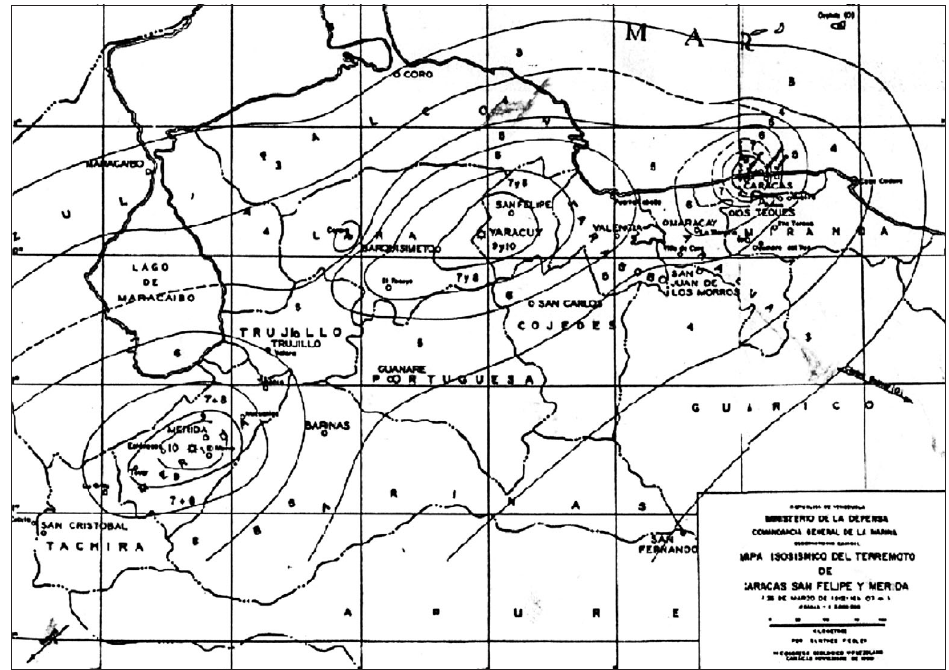
Fig. 4. Map of intensities for 1812, from Fiedler